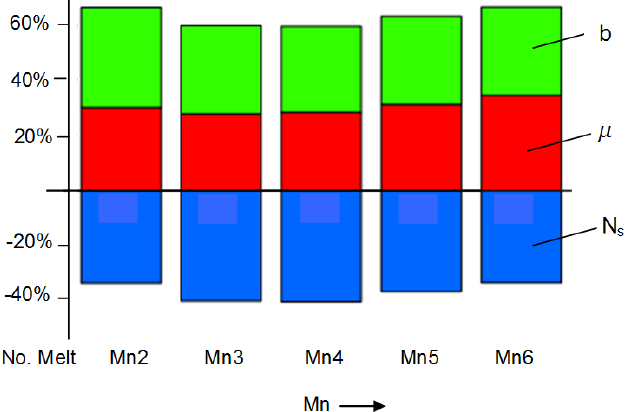
Figure 18. Manganese intensity effect on the CT index through μ, N s and b (− CT decreases; + CT